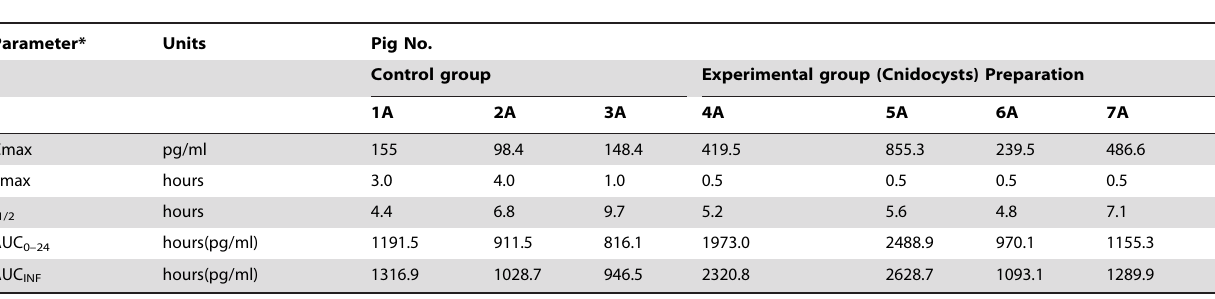
Table 1. Calculated pharmacokinetic parameters of scopolamine in pig plasma after a 5-minute topical application of the drug.